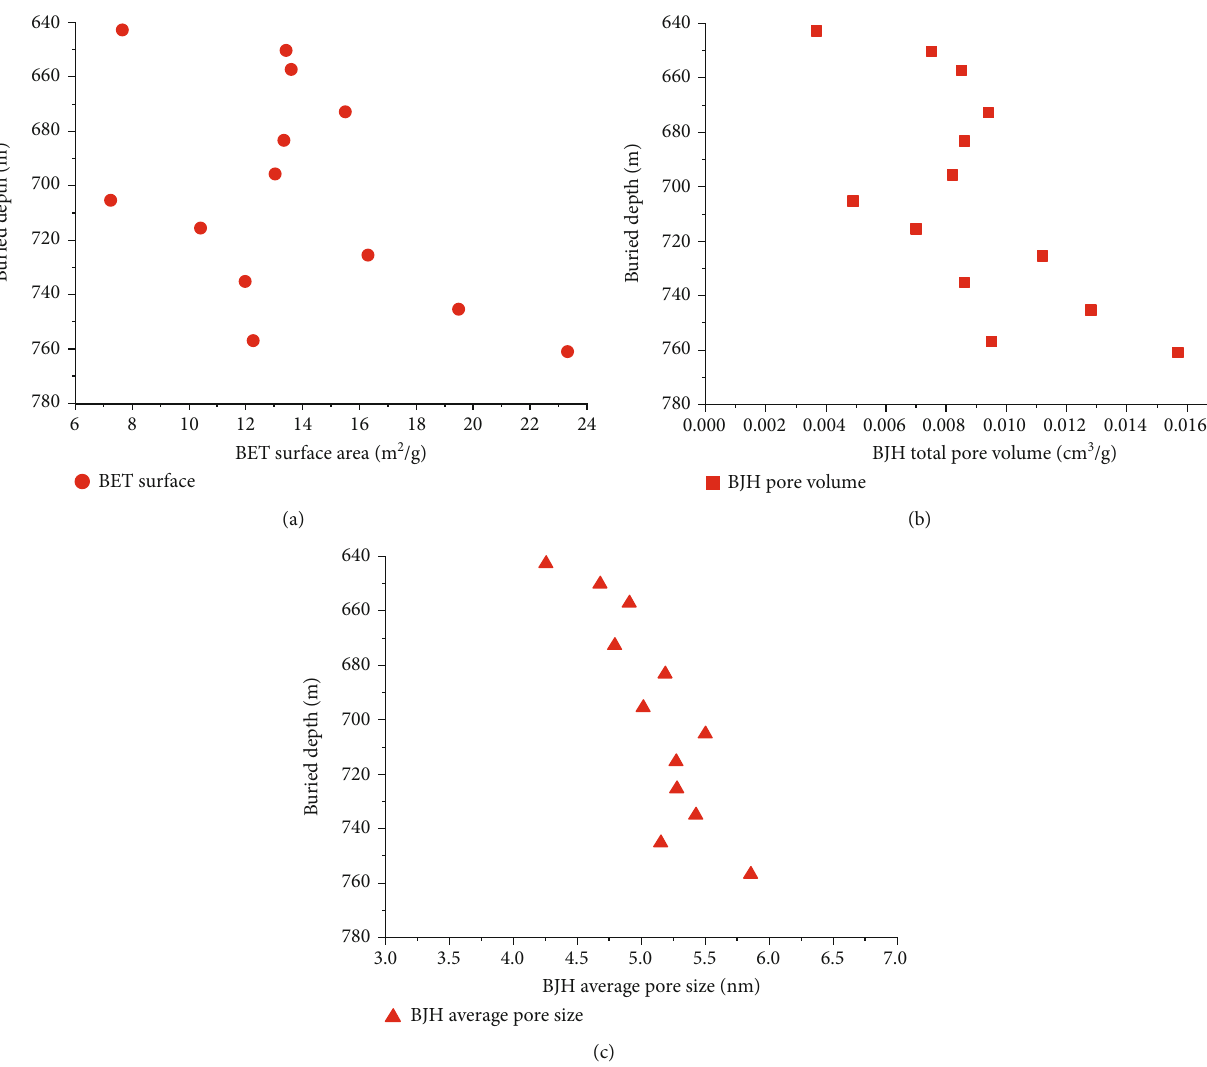
Figure 8: Pore system characterization of collected samples of WL shale in